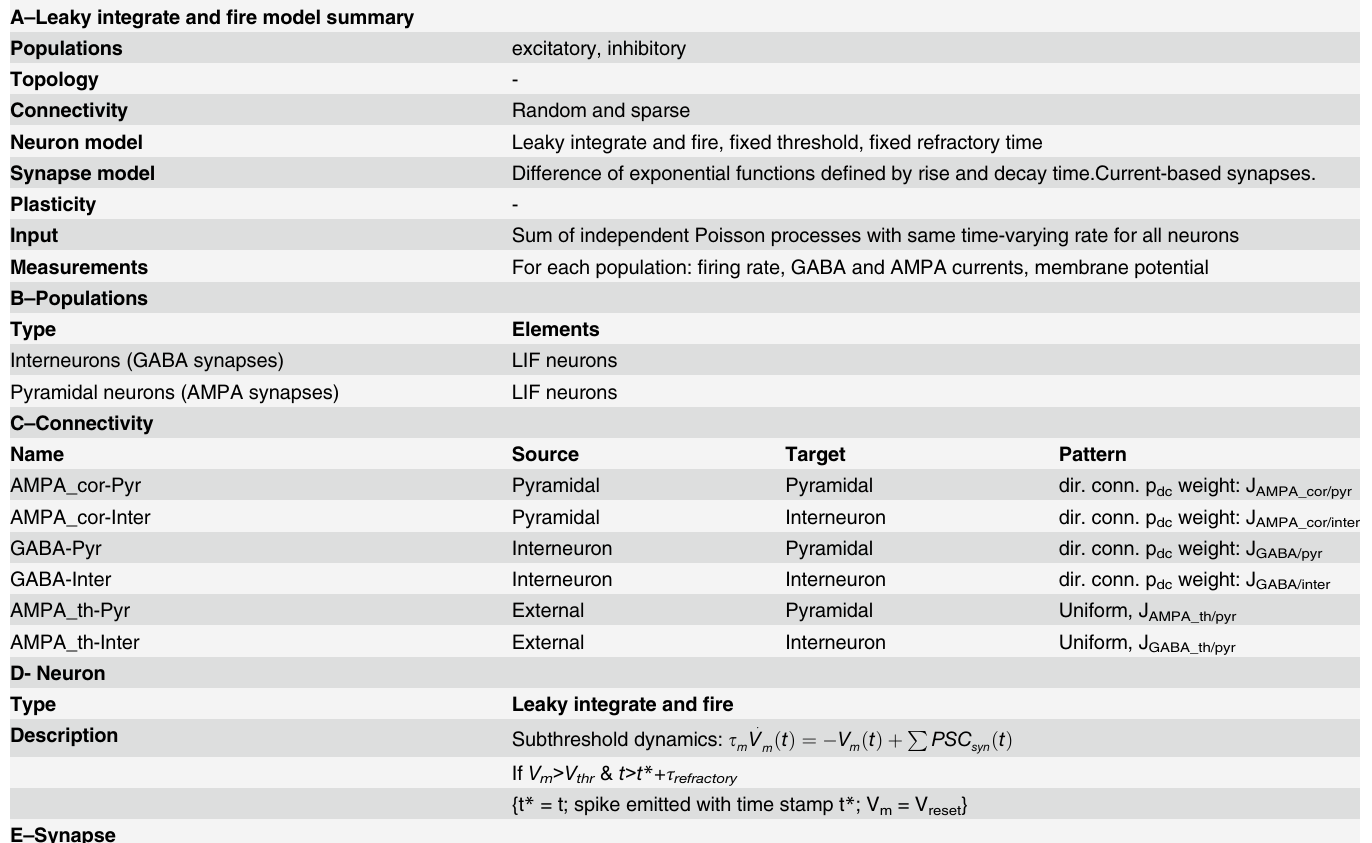
Table 1. Summary of leaky integrate-and-fire (LIF) network